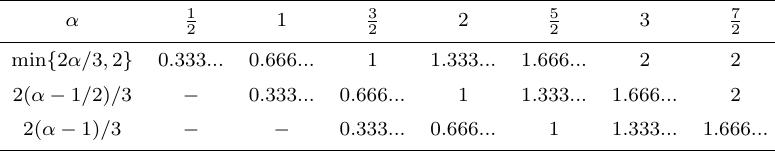
Table 1. The theoretical error orders in dependence on α α 1 1 3 2